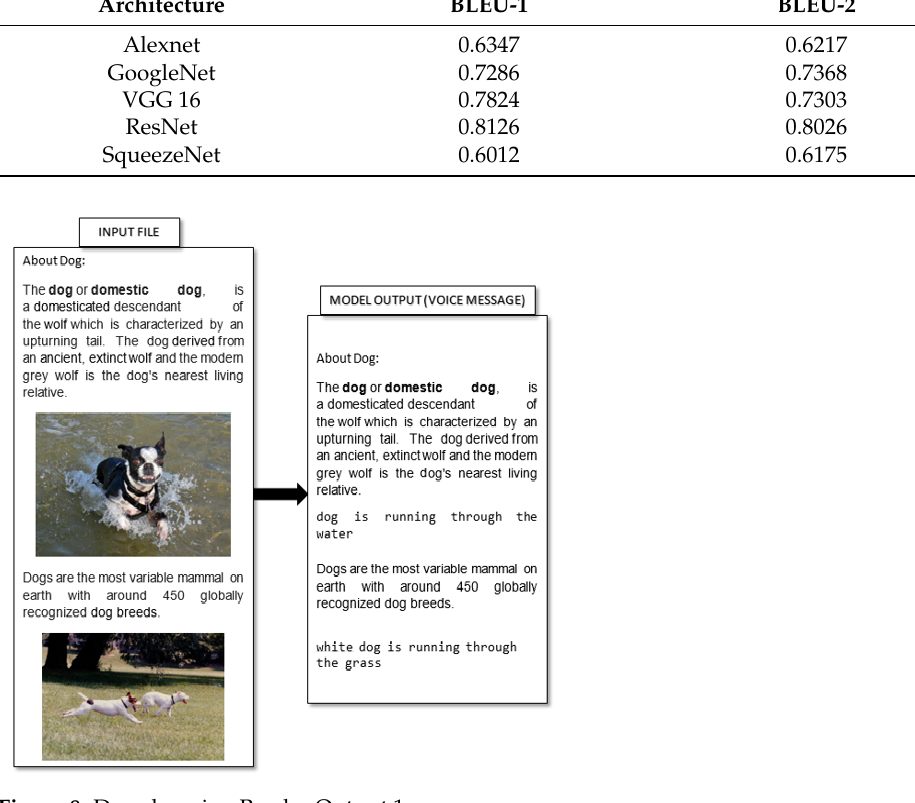
Figure 8. Deep learning Reader Output 1.